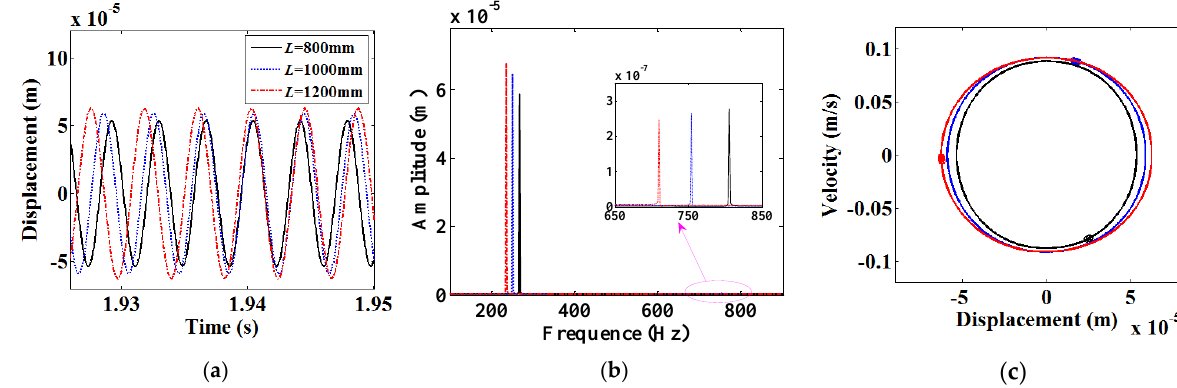
Figure 17. Vibration responses in the resonance region: ( a ) Time history; ( b ) Spectrum; ( c ) Phase diagram and Poincaré section.